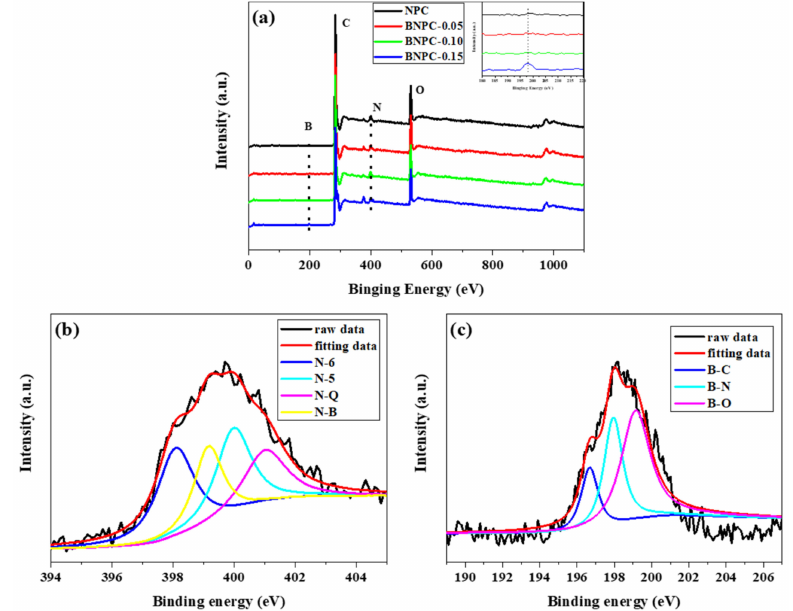
Figure 3. X-ray photoelectron spectroscopy (XPS) survey spectra of the NPC and BNPC-X ( a ), N 1s